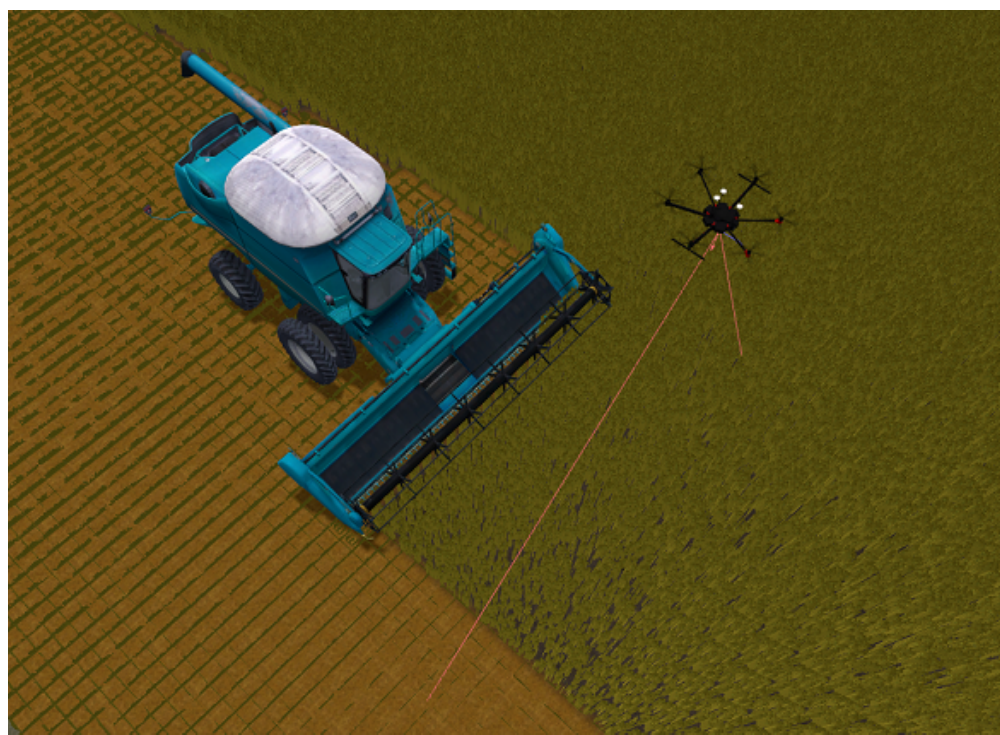
Figure 2. Automated harvesting process, with the unmanned aerial vehicle (UAV) in obstacle detection